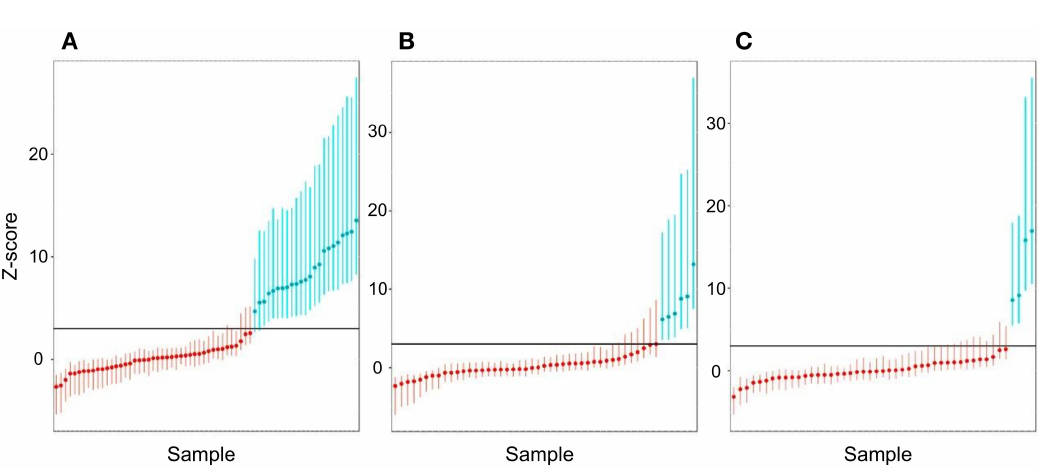
Figure 6. Histograms of Z -score values obtained during the cross-validation of control samples (( A )—T21, ( B )—T18, ( C )—T13 chromosome). Red indicates samples that did not have the corresponding aneuploidy, green indicates samples with aneuploidy. The maximum and minimum Z values for the sample in the simulations are plotted by error bars. SD values are given in Supplementary Table S4 of Supplementary Files. The black horizontal line in the histograms indicates Z = 3.